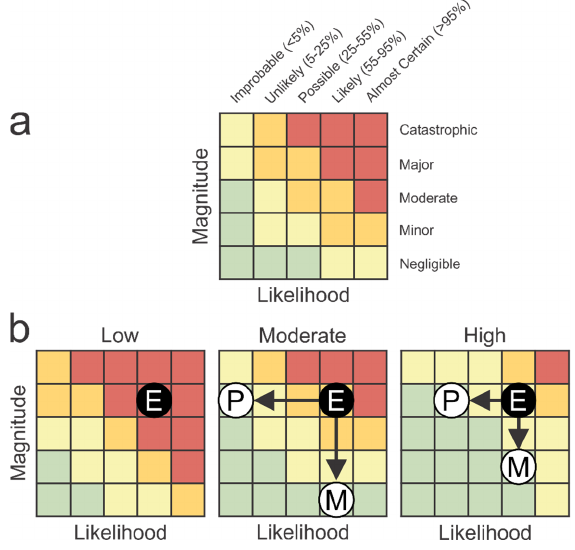
Figure 9. ( A ) Risk criteria and ( B ) risk tolerance matrices to evaluate if a management system should be changed (effects ( E ) are managed through mitigating ( M ) or preventative ( P ) measures). Coloration within the matrices denotes the necessary course of management action ( Green : No management measures required; Yellow : Existing management measures adequate; Orange : Existing management measures need enhancement, and Red : Additional management measures needed). Modified from [40,77].